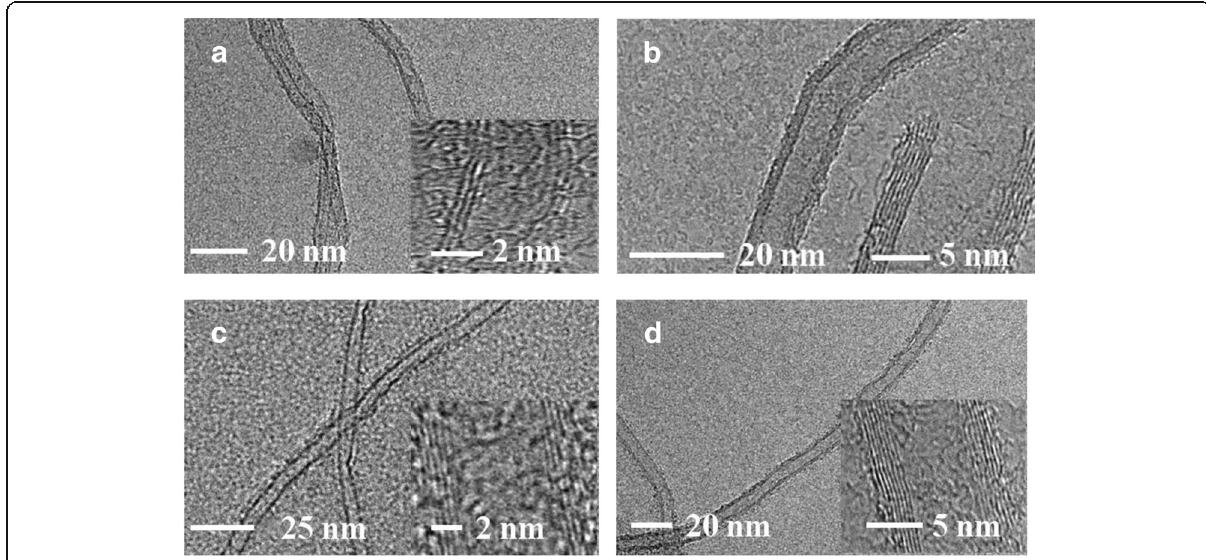
Fig. 5 TEM images of VACNTs grown on different buffer layers: a Al 2 O 3 , b TiO 2 , c ZnO, and d SiO 2